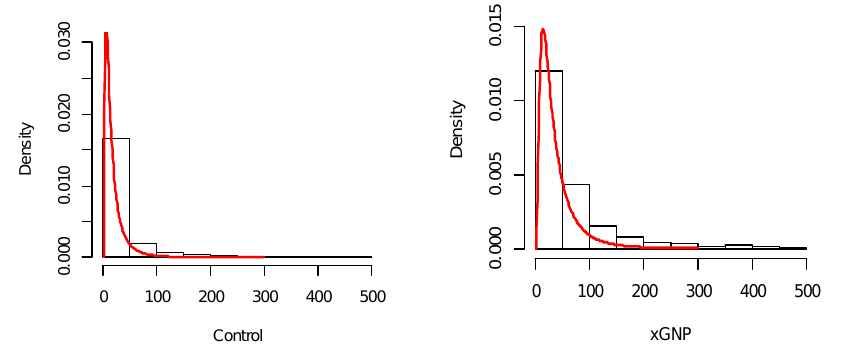
Figure 7. The histogram with the fitted lognormal distributions (the right plot for xGNP data, and the left plot from Control data; Bars represent the MD simulation data, and the red lines represent fitted lognormal curves; the data number in x -axis represents the viscosities of the asphalt binder model (viscosity unit: cp), and the distribution density was shown in y -axis; “control” in this figure means “control asphalt binder model” and “xGNP” means “xGNP modified asphalt binder model).